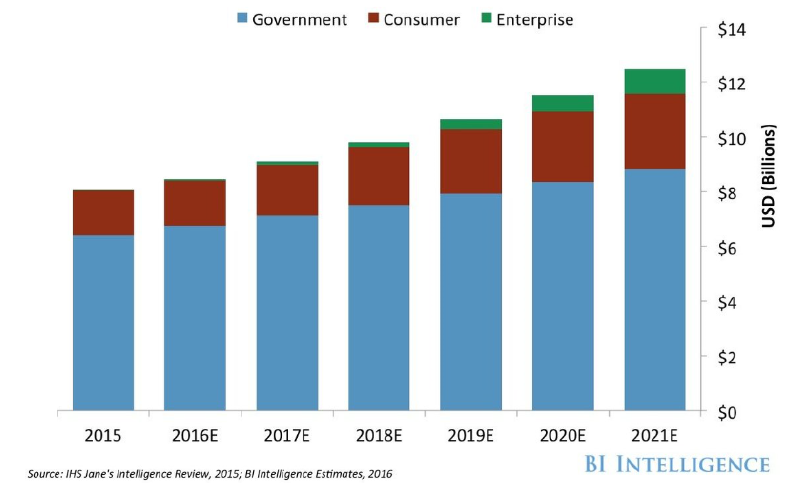
Figure 1. Estimated investment in drones in USD. As the need and application for drones increase over the years, the investment also increases